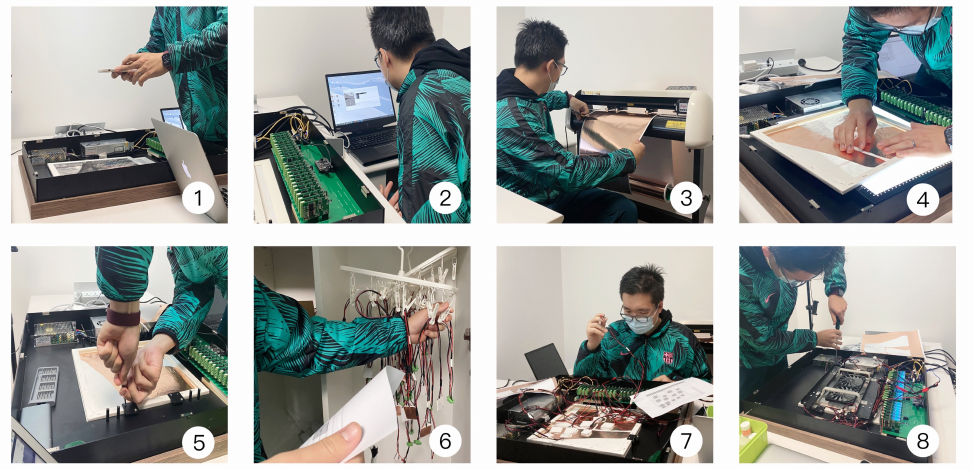
Figure 10. The use process of the toolkit: steps 1–2, design tool operation; steps 3–4, make the thermally conductive layer; steps 5–8, assemble the hardware components, including (5) the inner wooden picture frame, (6–7) the Peltier elements, and (8) the heat dissipation